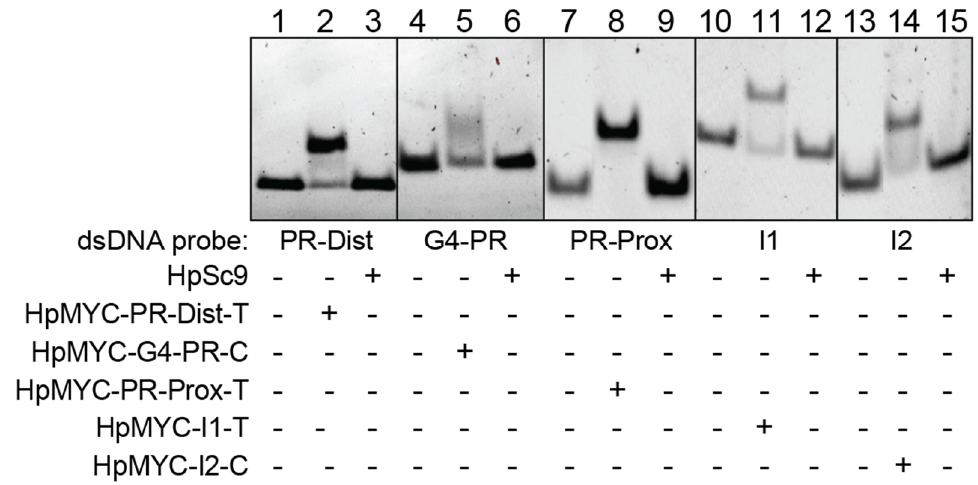
Figure 3. PPRH binding to target sequences in the MYC gene. Binding of HpMYC- PR-Dist-T, G4-PR-C, PR-Prox-T, I1-T, I2-C, and HpSc9 (1 µg) to the complementary FAM-labeled polypyrimidine target sequence dsDNA (200 ng). The length of the dsDNA probes was the same as each arm of the PPRHs, that is, ranging between 23 and 34 nucleotides. A supershift is noted for all binding pairs (e.g., dsDNA probes with the matched PPRH), but not scramble controls. The image is representative of at least 3 different EMSAs. Table 2. Melting temperatures (T Ms ) of the different polypyrimidine single-stranded targets (PPY) with their corresponding PPRH and